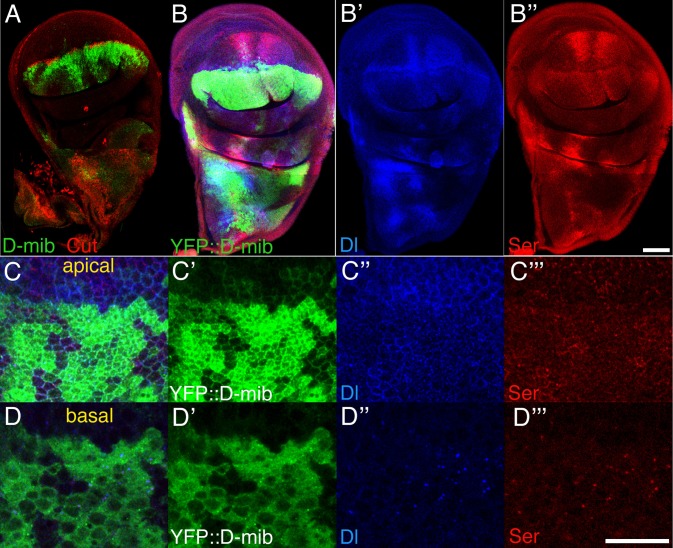
Expression of D-mib in Dorsal Cells Is Sufficient to Rescue the D-mib Mutant Phenotype(A) Expression of D-mib (green) in dorsal cells, using Ser-GAL4, rescued the growth of the wing pouch and margin Cut (red) expression in D-mib2/D-mib3 mutant discs.(B–D′′′) Ser-GAL4-driven expression of YFP::D-mib (green) rescued the D-mib2/D-mib3 phenotype and strongly reduced the level of Dl (blue in [B, B′, C, C′′, D, and D′′]) and Ser (red in [B, B′′, C, C′′′, D, and D′′′]) in dorsal cells. (C–D′′′) are high-magnification views (apical [C–C′′′] and basal [D–D′′′]) of the disc shown in (B–B′′). YFP::D-mib co-localized with Dl and Ser at the apical cortex in cells expressing only low levels of YFP::D-mib.Bar is 50 μm for (A–B′′) and 10 μm for (C–D′′′).